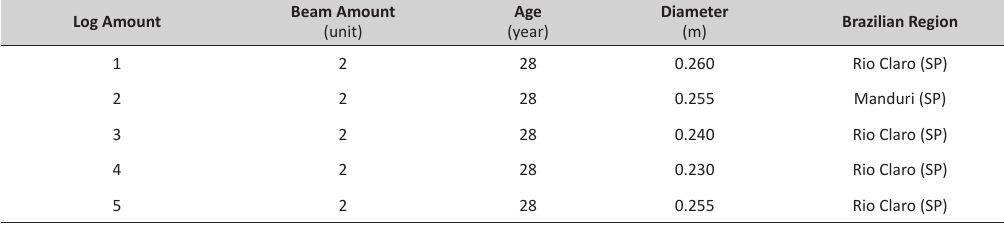
TAble 1. Aspects of the Eucalyptus maidenii